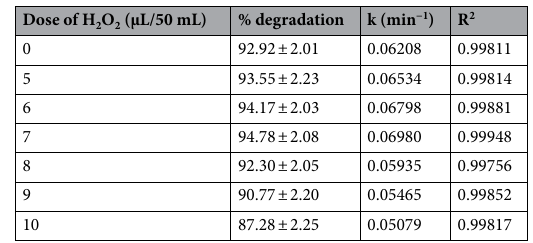
Table 5. Photodegradation chart of esomeprazole over In 2 O 3 /MoS 2 /Fe 3 O 4 at different doses of H 2 O 2 .